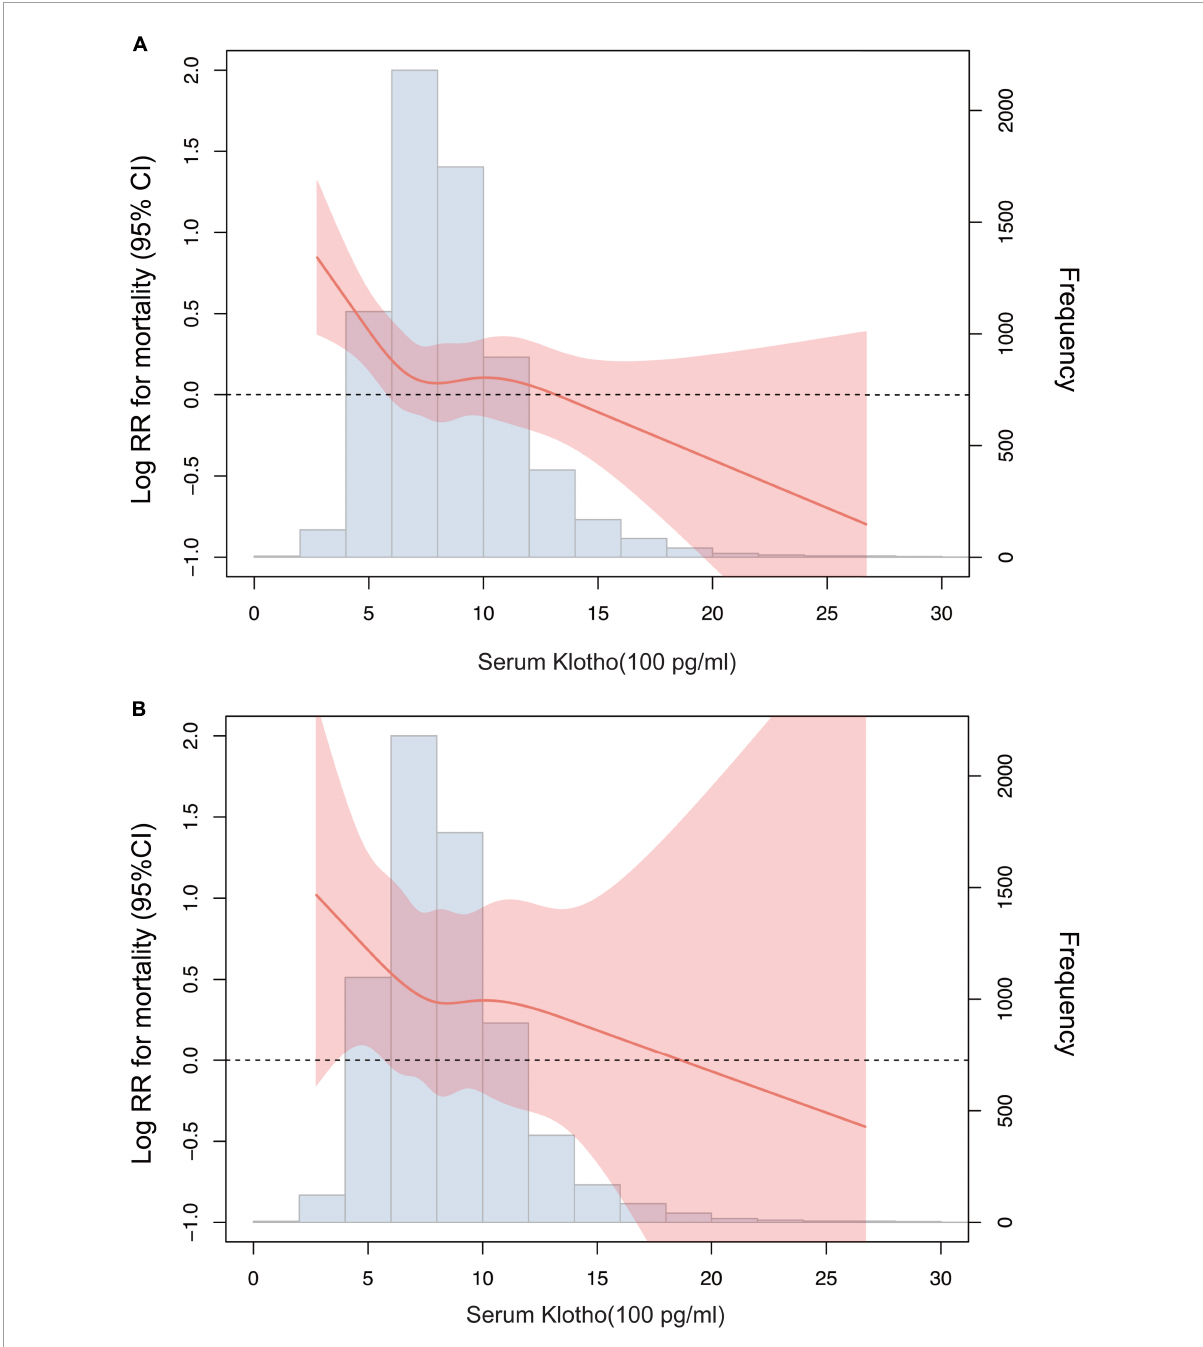
FIGURE3 Association of serum Klotho concentrations with all-cause mortality (A) and cardiovascular mortality (B) using a restricted cubic spline regression model. Log RR, Log relative risk. Results were adjusted for age, sex, race, education level, smoking, body mass index, Calcium, Phosphorus, 25-Hydroxyvitamin D, alkaline phosphatase, uric acid, blood urea nitrogen, creatinine, total cholesterol, high-density lipoprotein cholesterol, triglyceride, glycohemoglobin, comorbidities (cardiovascular disease, diabetes, and stroke), and medicine use (hypotensive drugs, hypoglycemic drugs, lipid-lowering medication, and antiplatelet drugs).